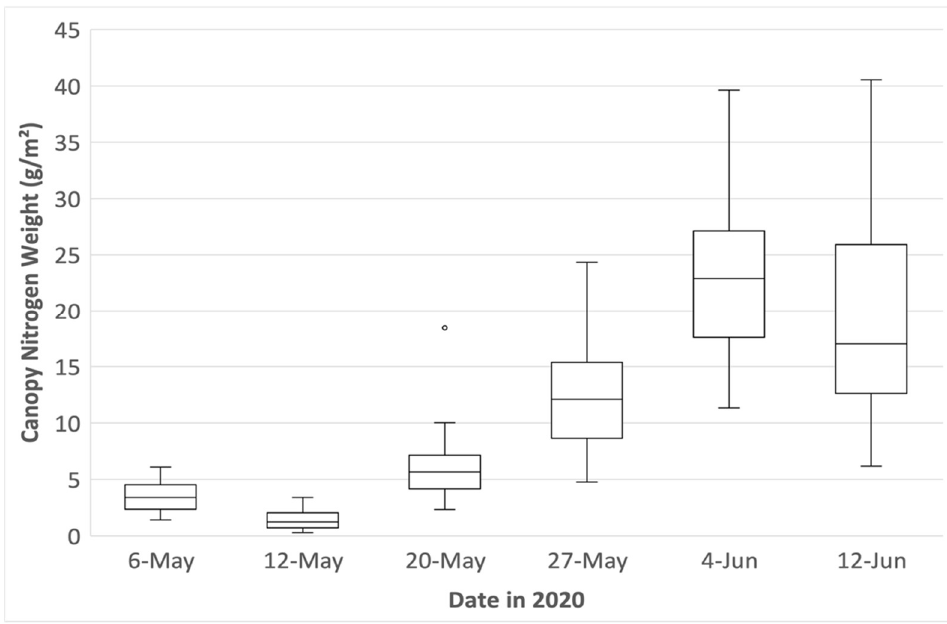
Figure 4. Variation of canopy nitrogen weight (g/m 2 ) as a function of the date of field measurements during the 2020 growing season. An outlier is represented by a dot on the graph.